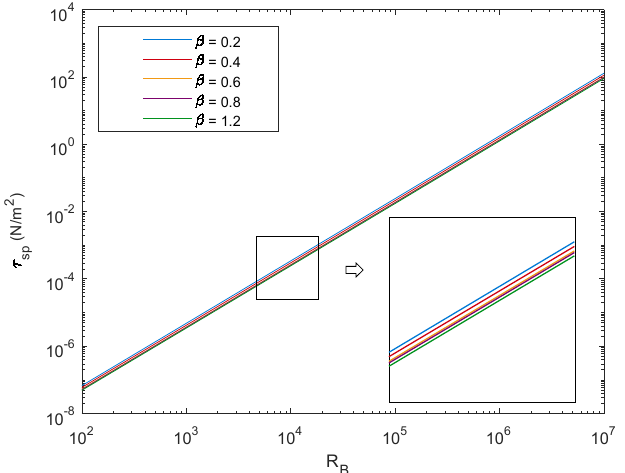
Figure 3. Variations of the sea spray droplet momentum flux, as a function of R B under different wave ages.